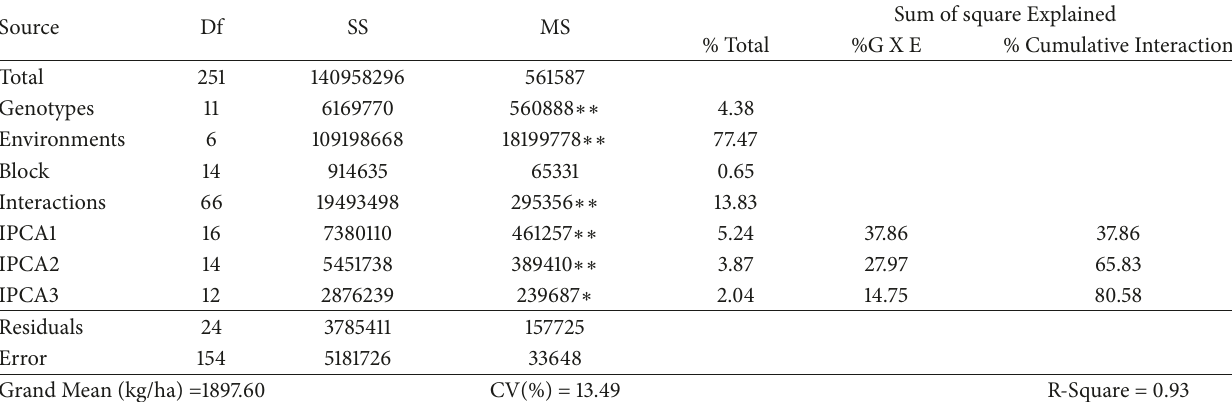
Table 4: Additive main effects and multiplicative interaction (AMMI) analysis of variance for grain yield (Kg ha −1 ) of field pea genotypes across seven